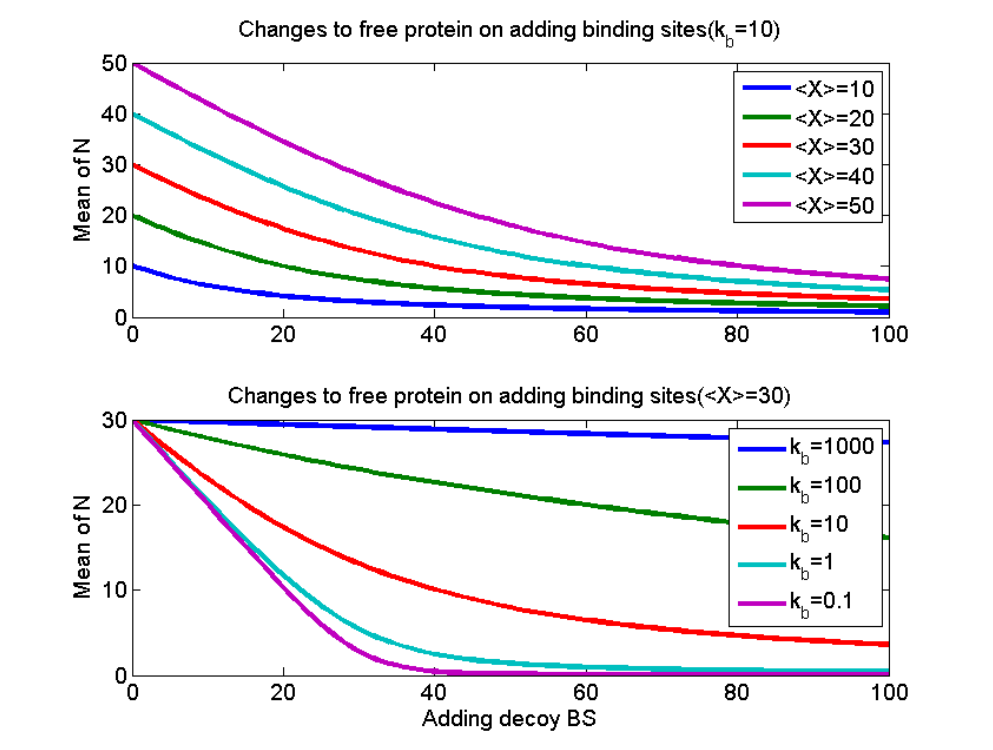
Fig. 3: Mean of free protein probability distribution